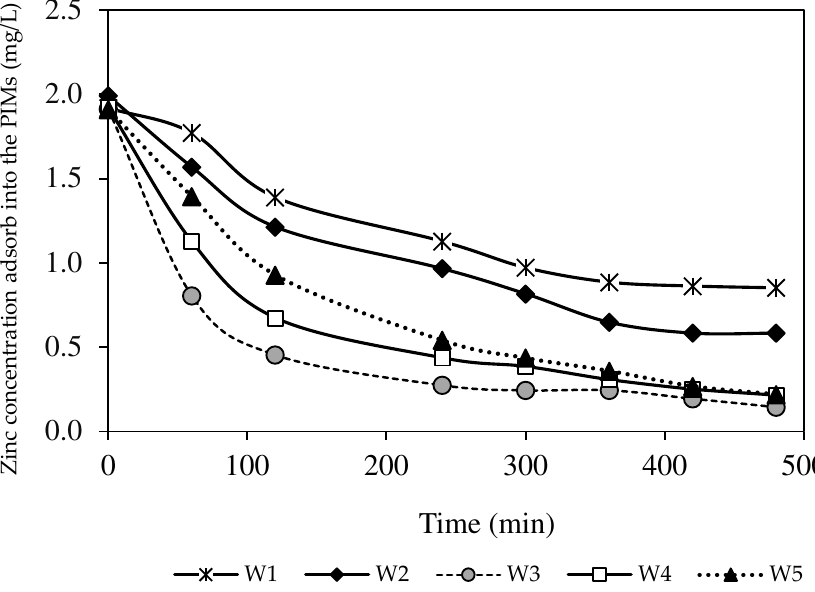
Figure 11. The removed Zn 2+ percentages absorbed into the PIM and MM-PIM membranes.